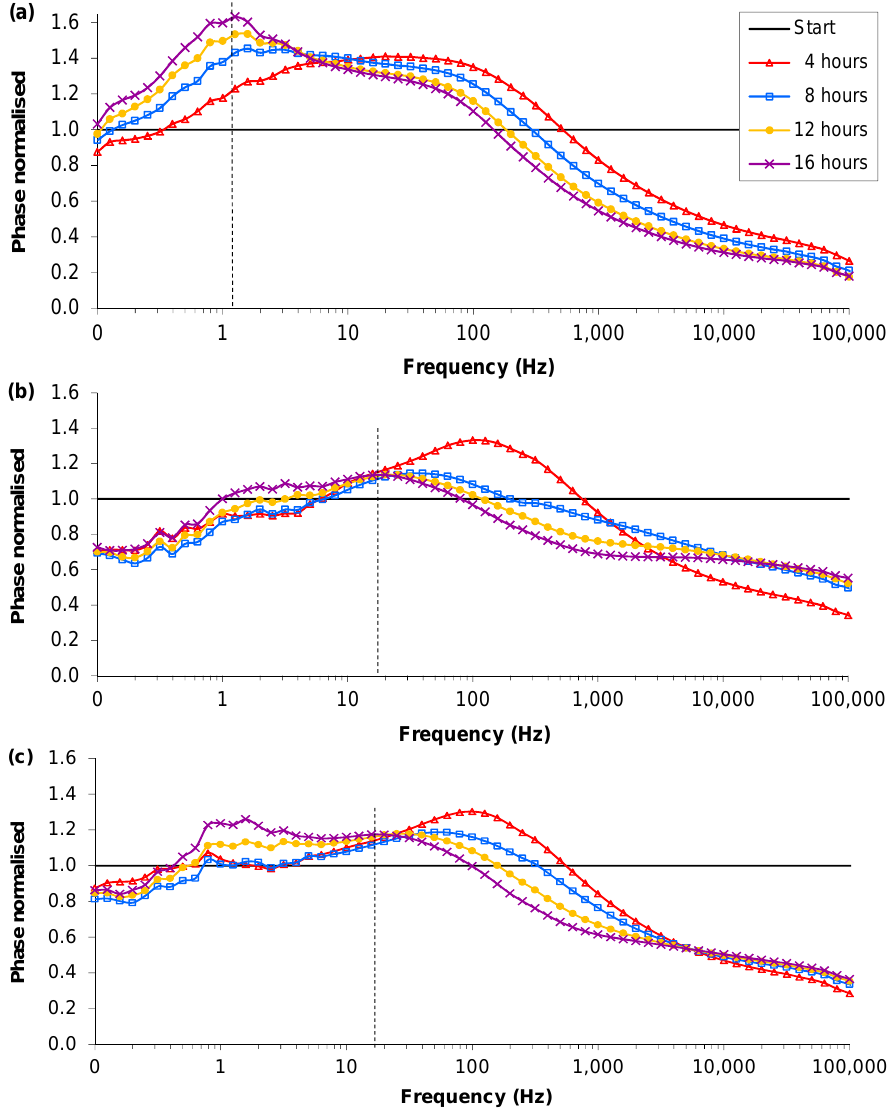
Figure 2. Examples of the normalised phase angle profiles from the single suspension experiments: ( a ) Control, MHB-only; ( b ) RN4220 culture 1; ( c ) RN4220 culture 2. Dotted line indicates the normalized phase angle